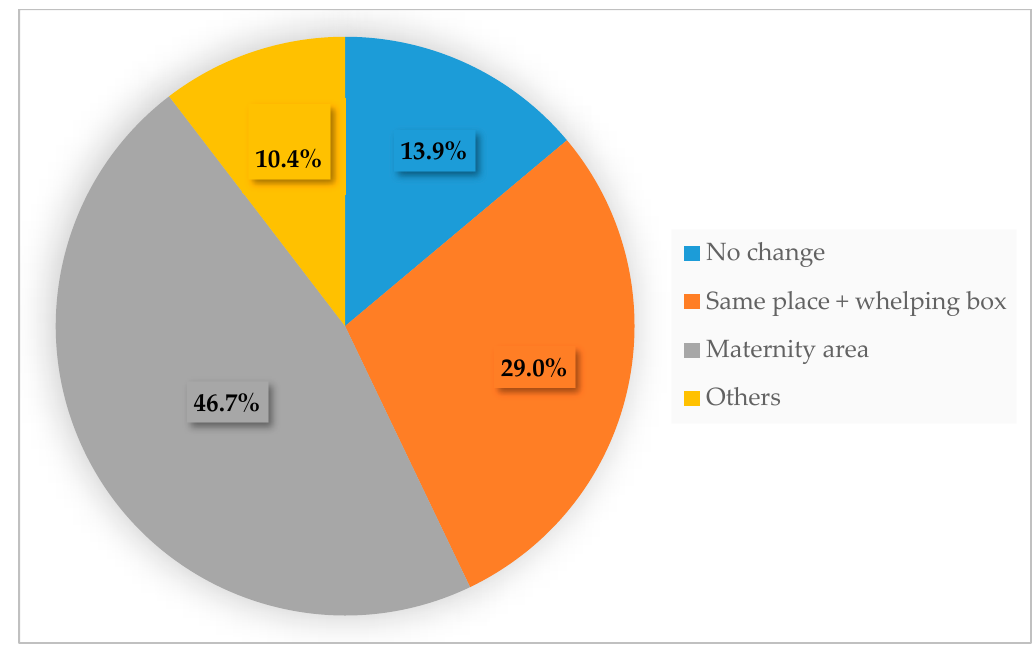
Figure 4. Housing of the breeding bitches during the peripartum period (percentages, multiple answers allowed).